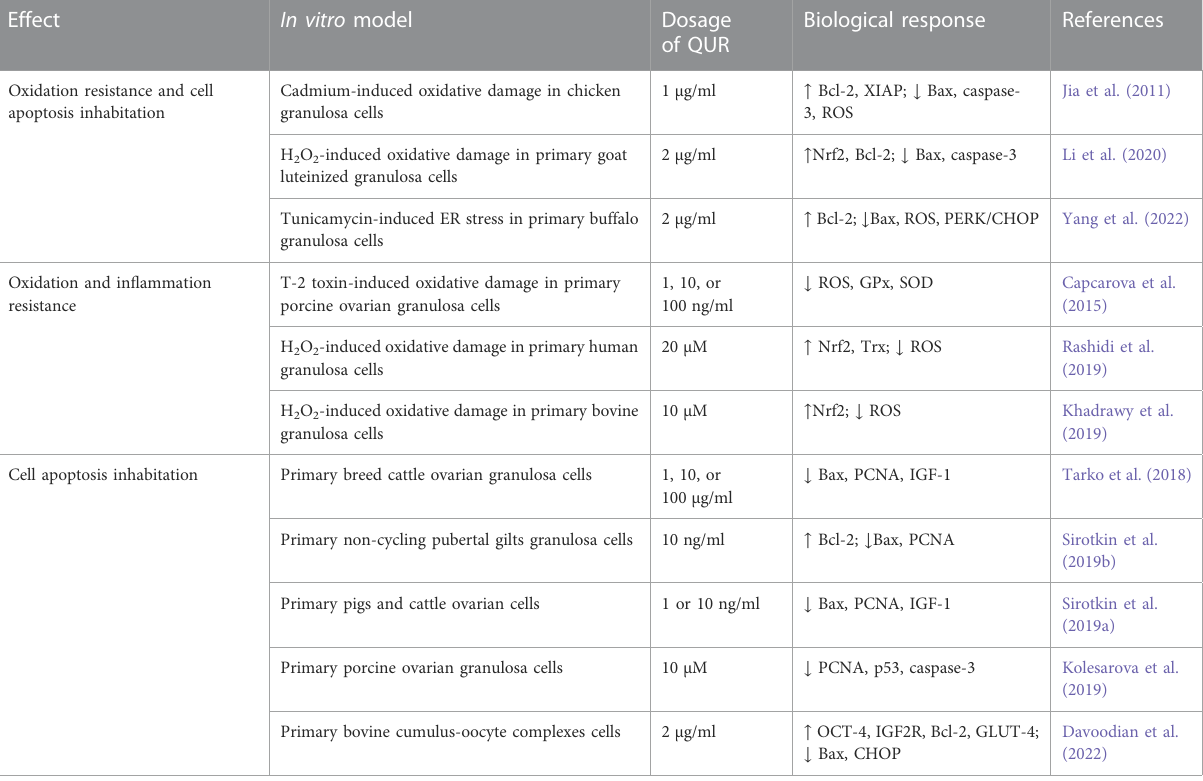
TABLE 1 Effects of In vitro studies of QUR on Ovarian